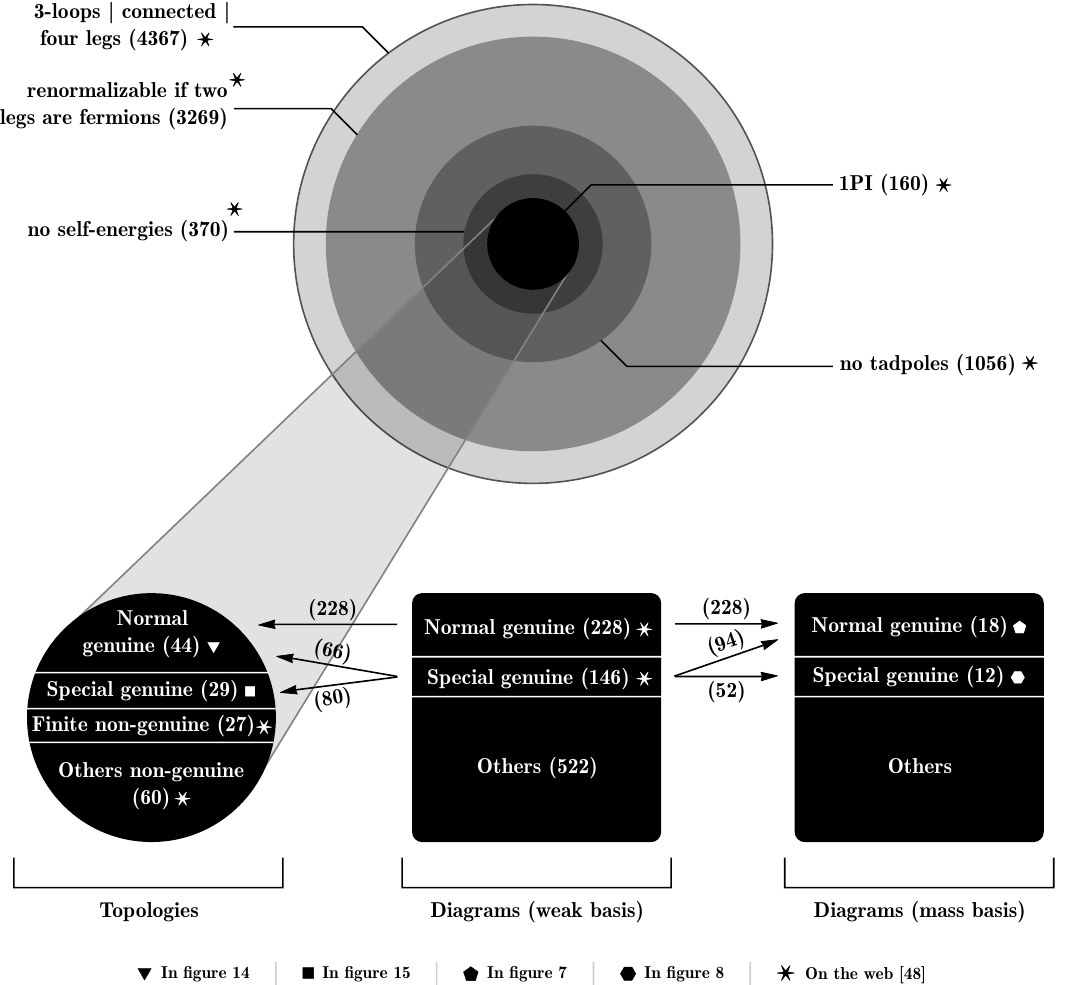
Figure 9 . Summary of the di(cid:11)erent types of diagrams and topologies. Out of thousands of topologies, only 160 are potentially interesting. They correspond to a total of 896 diagrams: